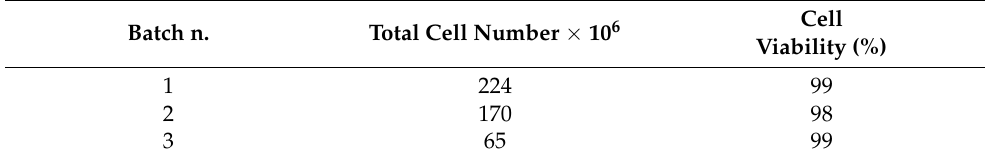
Table 1. Lyosecretome batch production from three different equine AD-MSCs lines. Batch n.